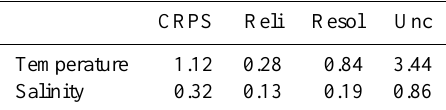
Table 2. Same as Table 1 for